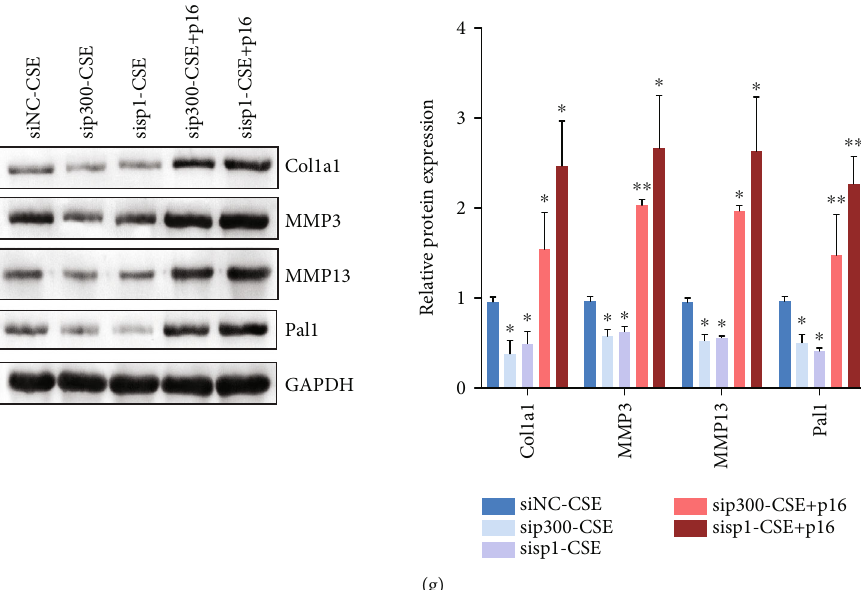
Figure 6: Low expression of p300/Sp1 inhibited CSE-mediated cell senescence. (a) Peripheral blood EPCs were treated with 5% CSE, p300/Sp1 were knocked down by siRNA, and the proportion of senescence cells was counted by β -galactosidase staining. (b) Peripheral blood EPCs were treated with 5% CSE, p300/Sp1 were knocked down by siRNA, and the expression of Lamp1 expression was detected by immuno fl uorescence. (c) Peripheral blood EPCs were treated with 5% CSE, p300/Sp1 were knocked down by siRNA, and cell cycle distribution was detected by fl ow cytometry. (d) Peripheral blood EPCs were treated with 5% CSE, p300/Sp1 were knocked down by siRNA, and the expressions of senescence-related genes Col1a1, MMP3, MMP13, and Pal1 were detected by RT-PCR. (e) Peripheral blood EPCs were treated with 5% CSE, p300/Sp1 were knocked down by siRNA, and the expressions of senescence-related genes Col1a1, MMP3, MMP13, and Pal1 were tested by Western Blot. (f) Peripheral blood EPCs were treated with 5% CSE, p300/Sp1 were knocked down by siRNA, p16 was overexpressed, and the expressions of senescence-related genes Col1a1, MMP3, MMP13, and Pal1 were detected by RT-PCR. (g) Peripheral blood EPCs were treated with 5% CSE, p300/Sp1 were knocked down by siRNA, p16 was overexpressed, and the expressions of senescence-related genes Col1a1, MMP3, MMP13, and Pal1 were tested by Western Blot. All the EPCs used in this fi gure were from nonsmoking non-COPD patients. ∗ p < 0 : 05 , ∗∗ p < 0 : 01 , and ∗∗∗ p < 0 : 001